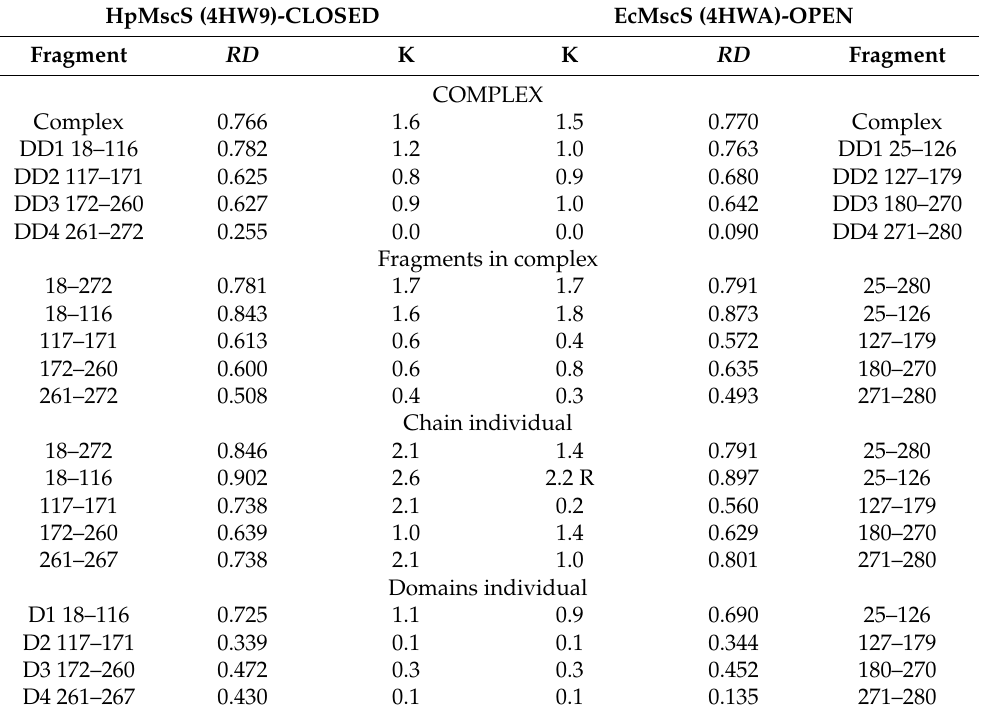
Table 2. A set of parameter values describing the statuses of the complexes, chains, and domains of proteins representing the mechanosensitive channels of HpMscS and EcMscS, treated as components of the complex and as individual structural units.